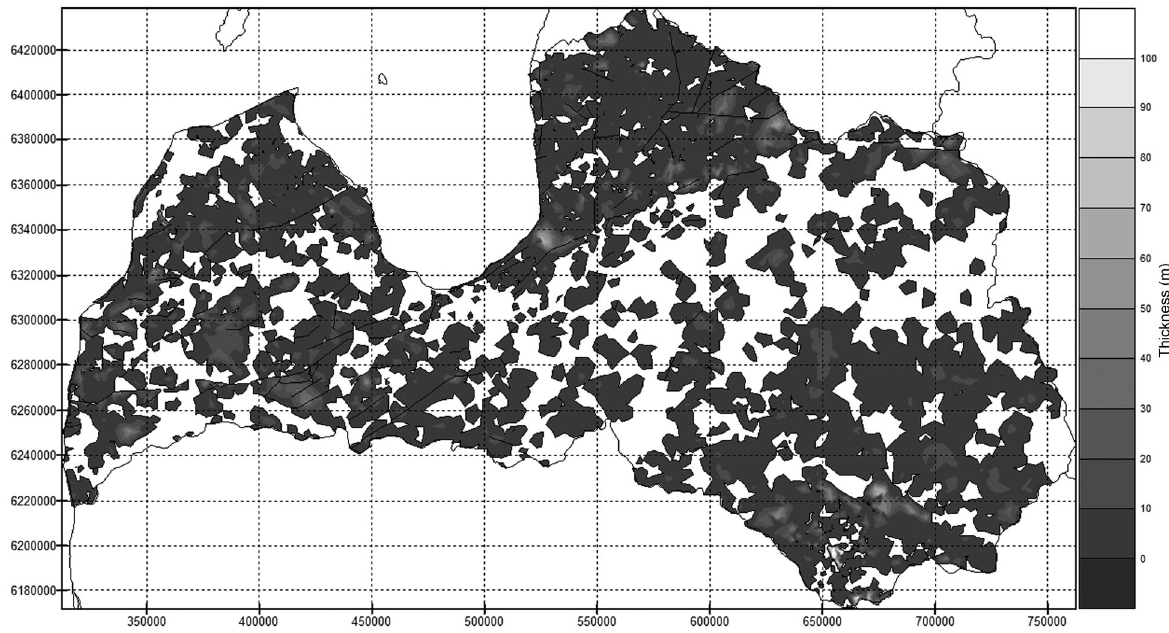
Fig. 6. Thickness offset between the Quaternary erosion surface and underlying layers. In blank areas the offset is zero. Coordinates given in the TM Baltic 93 coordinate